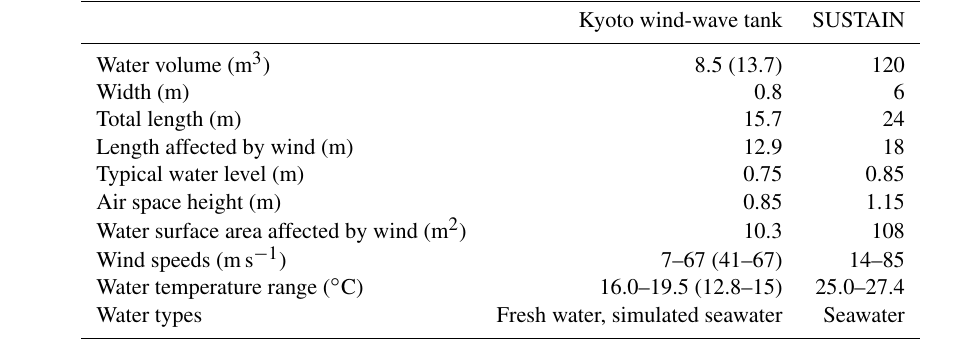
Table 2. Tracers used in this study. PFE: C 2 HF 5 , HFB: hexafluo- robenzene, DFB: 1,4-difluorobenzene, DMS: dimethyl sulfide, MA: methyl acetate. Solubility and Schmidt number are given at 20 ◦